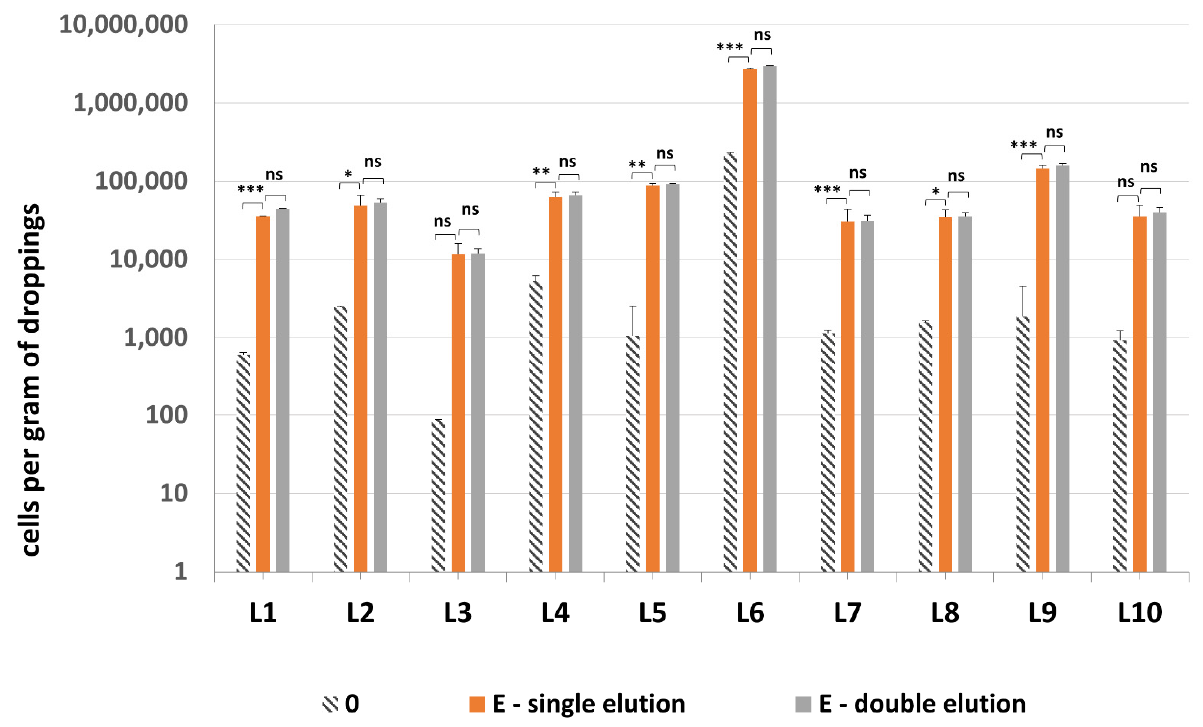
Figure 8. The quantification results of methanogenic archaea in samples L1–L10. Statistical signifi- cance between the non-mechanically-lysed controls (0), lysis variants E with single and double elution is marked by asterisks. Values of * p < 0.05, ** p < 0.01 and *** p < 0.001 were regarded as signif- icant. NS; not-significant.